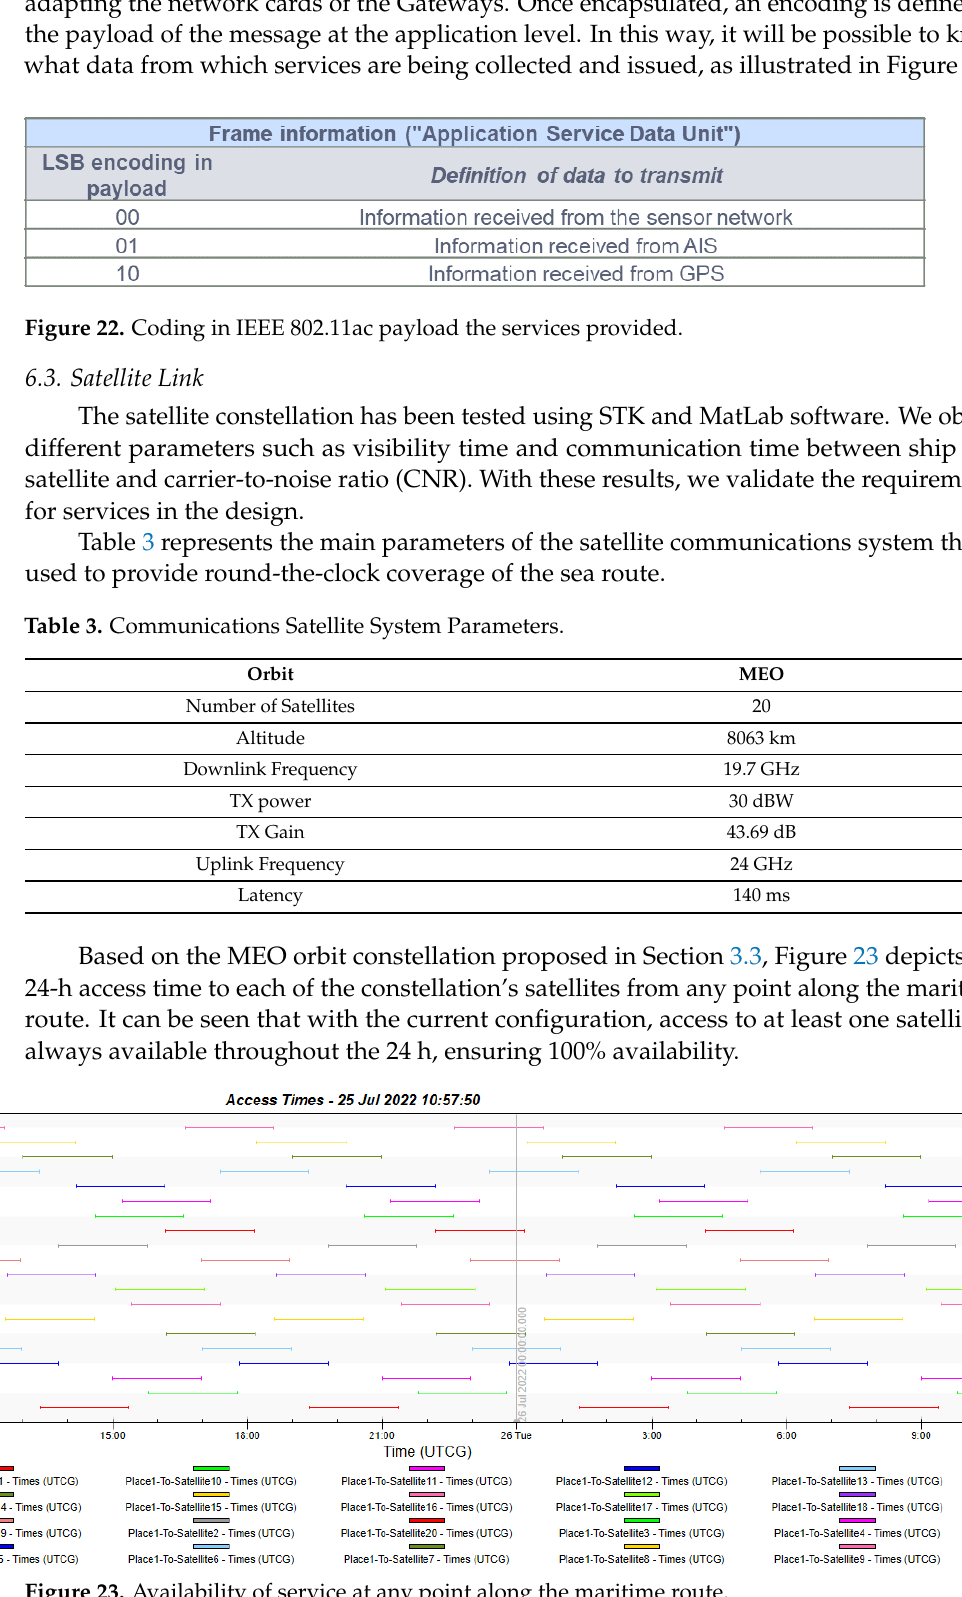
Figure 23. Availability of service at any point along the maritime